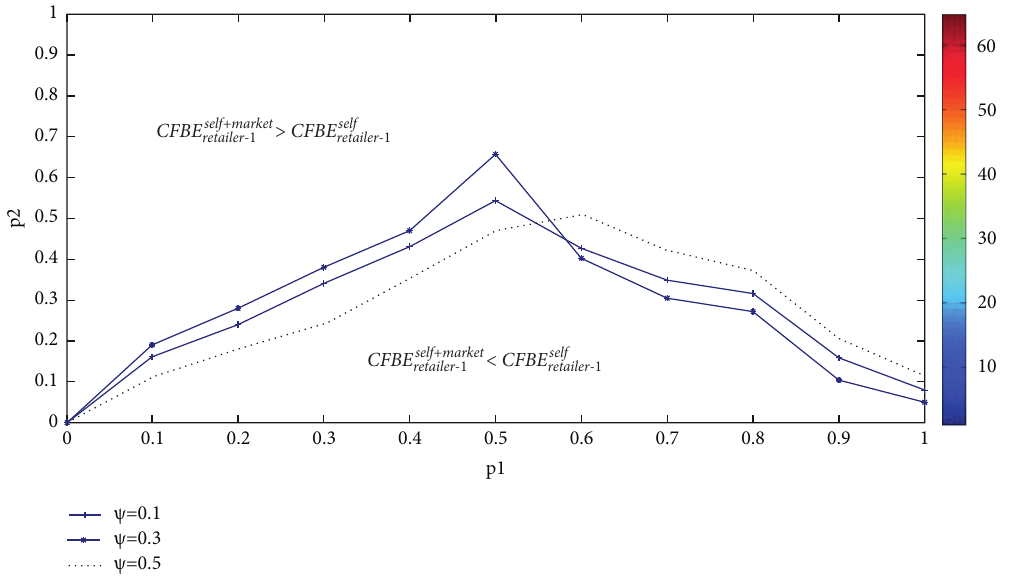
Figure 3: The impact of b